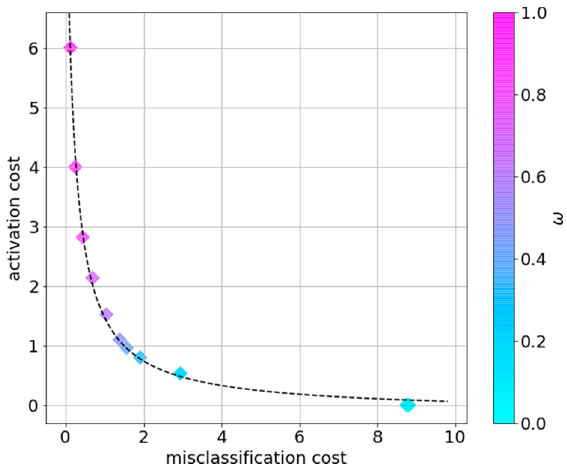
Figure 6. Activation costs vs. misclassification costs per ω , averaged over all patients .